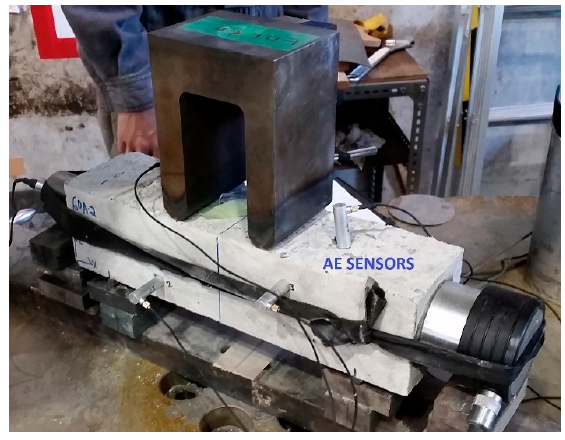
Figure 6. Acoustic emission and four-point bending test setup.